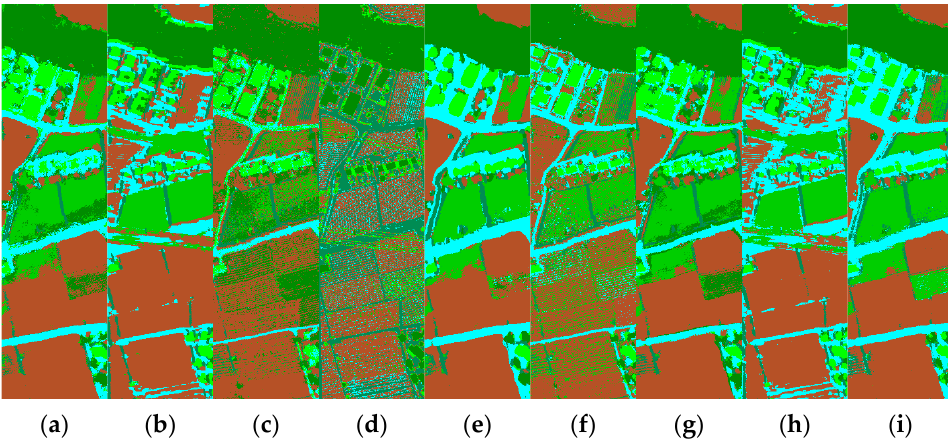
Figure 6. Classification maps obtained by different methods for the Trento dataset. ( a ) CNN-H; ( b ) CNN-L; ( c ) miniGCN-H; ( d ) miniGCN-L; ( e ) CCNet-HL; ( f ) CGNet-HL; ( g ) DCCGNet-H; ( h ) DCCGNet-L; ( i ) DCCG-HL.